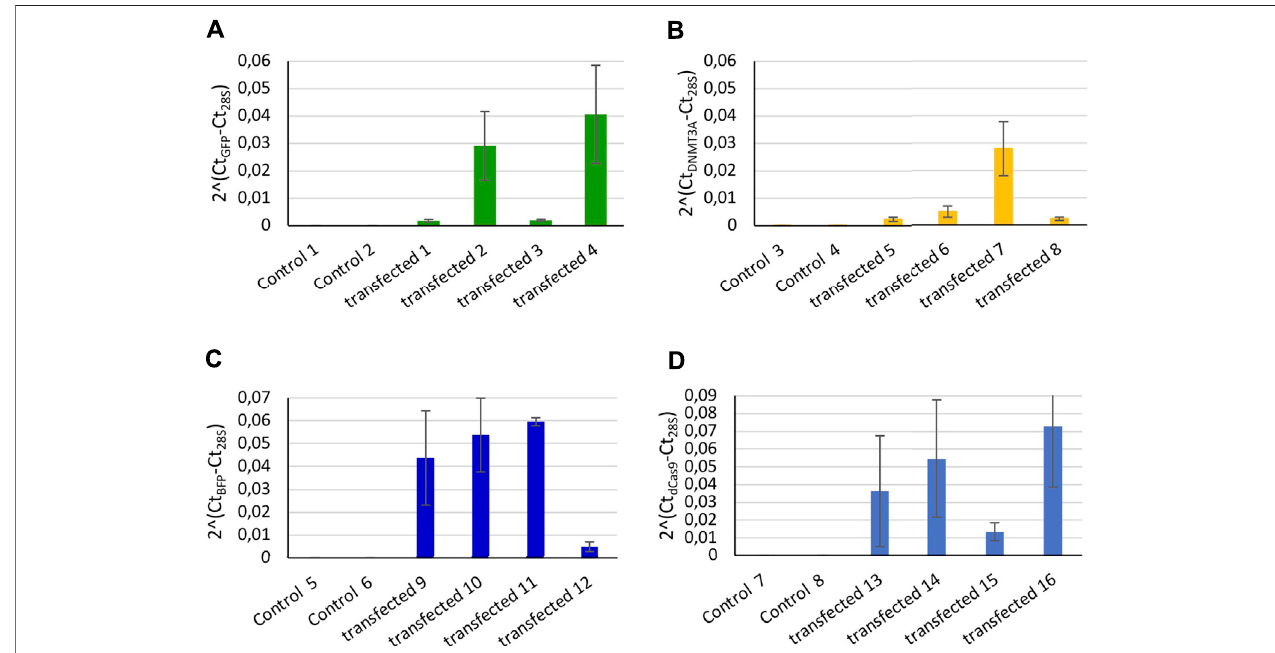
FIGURE 1 | Relative expression of controls (microinjected with only in vivo jetPEI reagent) and transfected snails (microinjected with in vivo jetPEI and the two plasmids coding for the dCas9-SunTag-DNMT3A system). Relative expression of (A) GFP, (B) DNMT3A, (C) BFP, and (D) dCas9 from transfected embryos. Two controls snails were compared to 4 transfected embryos per mRNA, each bar represents two technical replicates of the cDNA extracted from a single larva. Error bars correspond to standard deviation of the two technical replicates from each larva.